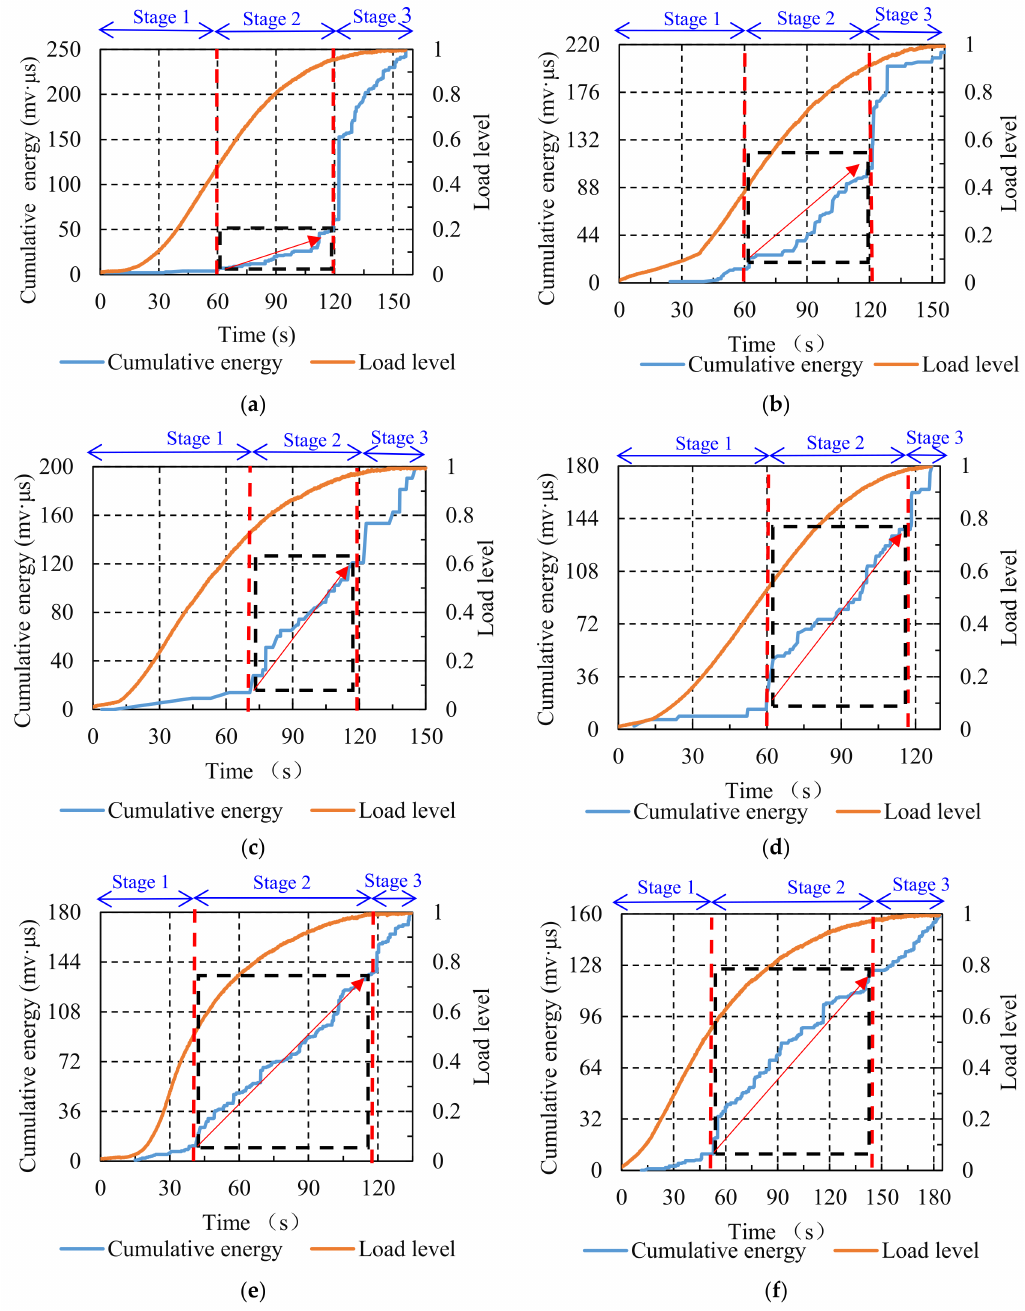
Figure 10. Cumulative energy distribution of specimens treated with various aging conditions: ( a ) 0 h; ( b ) STA; ( c ) LTA of 24 h; ( d ) LTA of 72 h; ( e ) LTA of 20 h; ( f ) LTA of 168 h. (Red arrow: rising speed of the